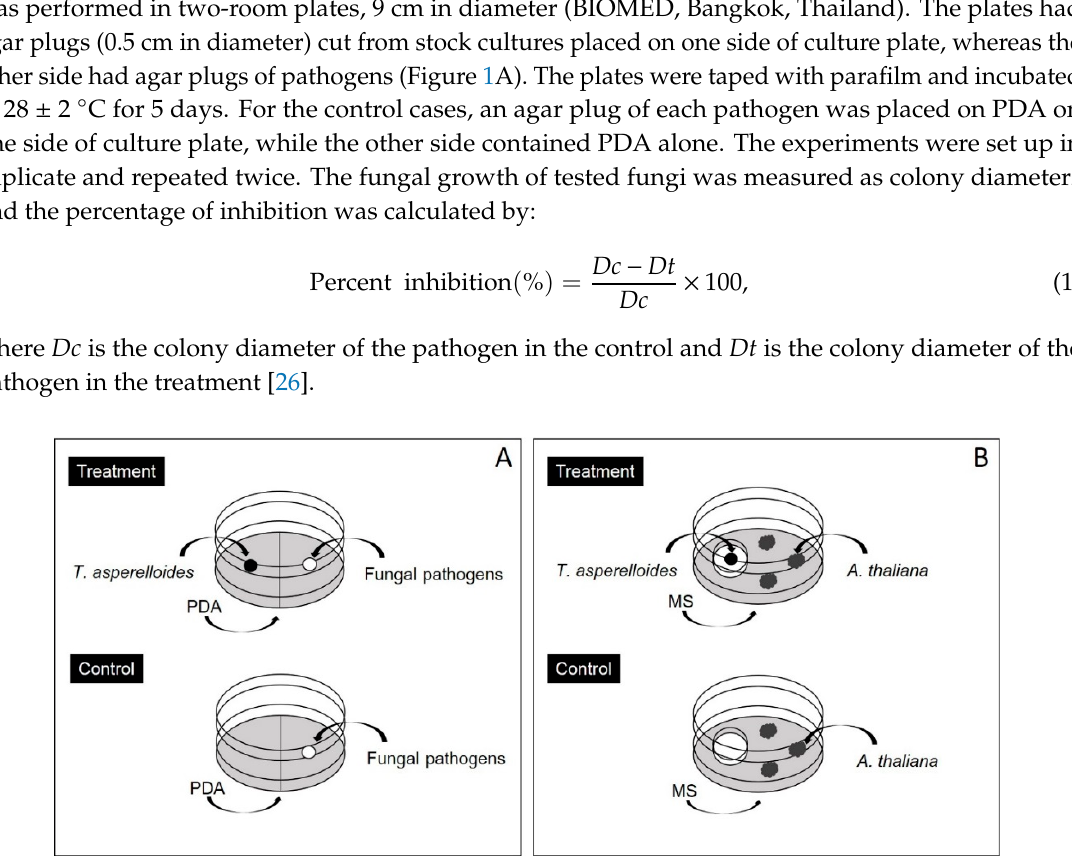
Figure 1. Overview of the experimental setup and the effect of volatile organic compounds (VOCs) on fungal growth, induced defense responses, and increased growth. A schematic overview of the plate-within-a-plate system for fungal growth ( A ) and for plant growth ( B ). PDA, potato dextrose agar; MS, Murashike and Skoog